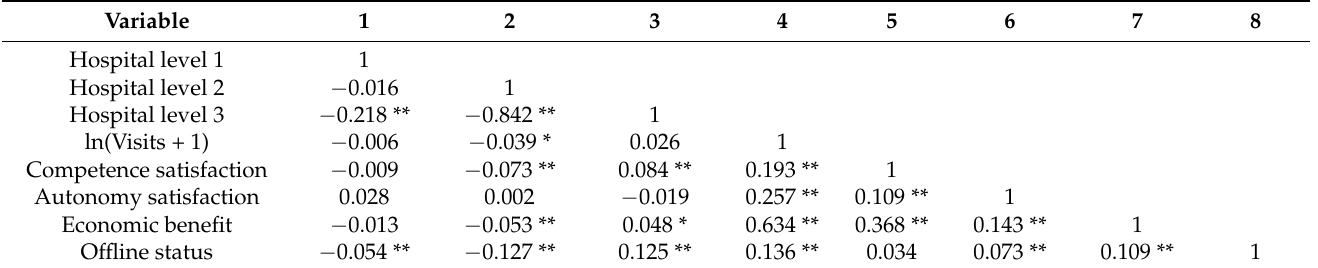
Table 3. Correlations of variables ( n =